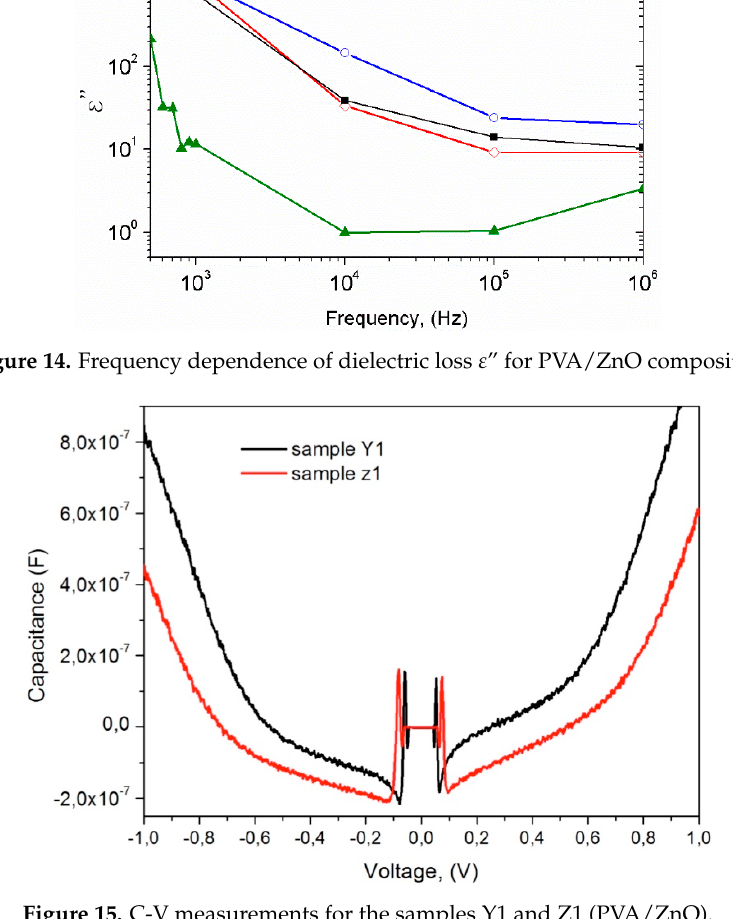
Figure 15. C-V measurements for the samples Y1 and Z1 (PVA/ZnO).